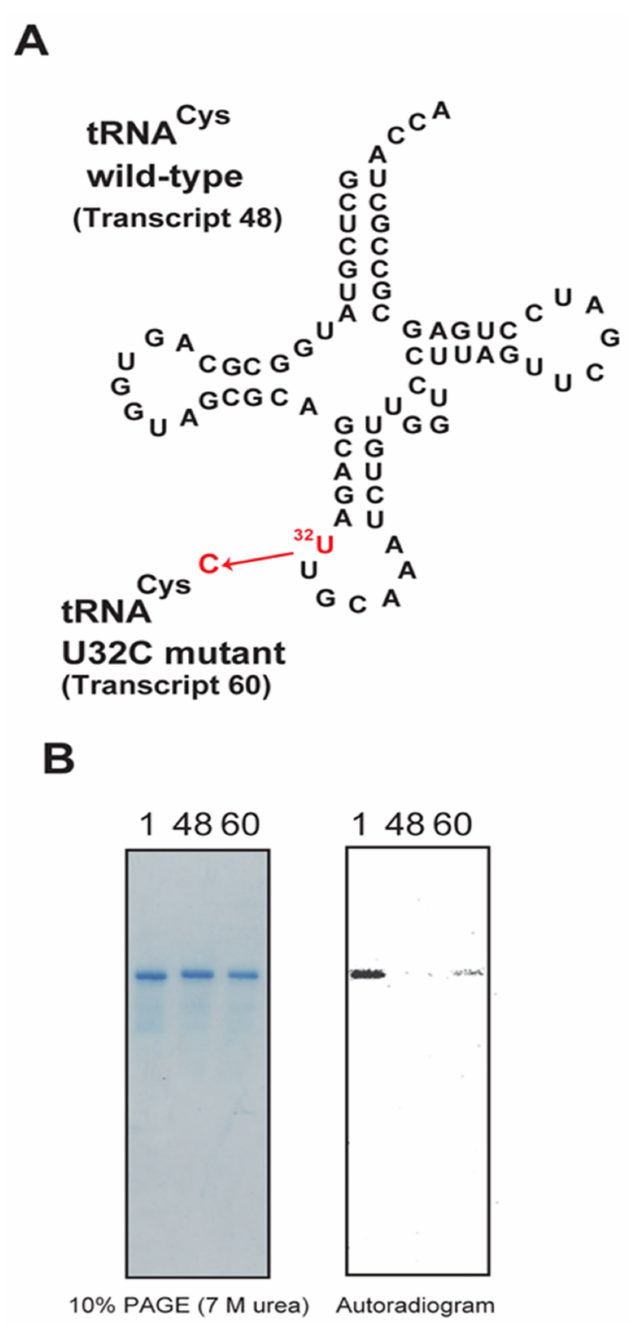
Figure 10. Acceptances of the methyl groups of the wild-type and mutant tRNA Cys transcripts by the Trm11-Trm112 complex were compared. ( A ) The sequence of tRNA Cys is represented in the cloverleaf structure. The U32 was replaced by C (transcript 60). ( B ) Acceptances of the methyl group of tRNA Phe , tRNA Cys and mutant tRNA Cys transcripts are